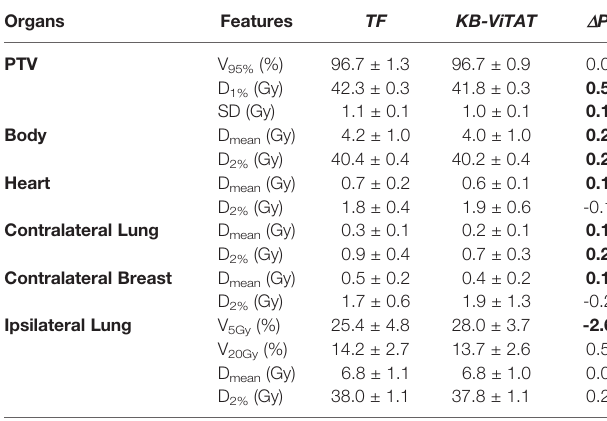
TABLE 4 | Dose-volume parameters comparison (TF vs ViTAT) for the validation cohort test of 30 plans for the right-sided breast case. Organs